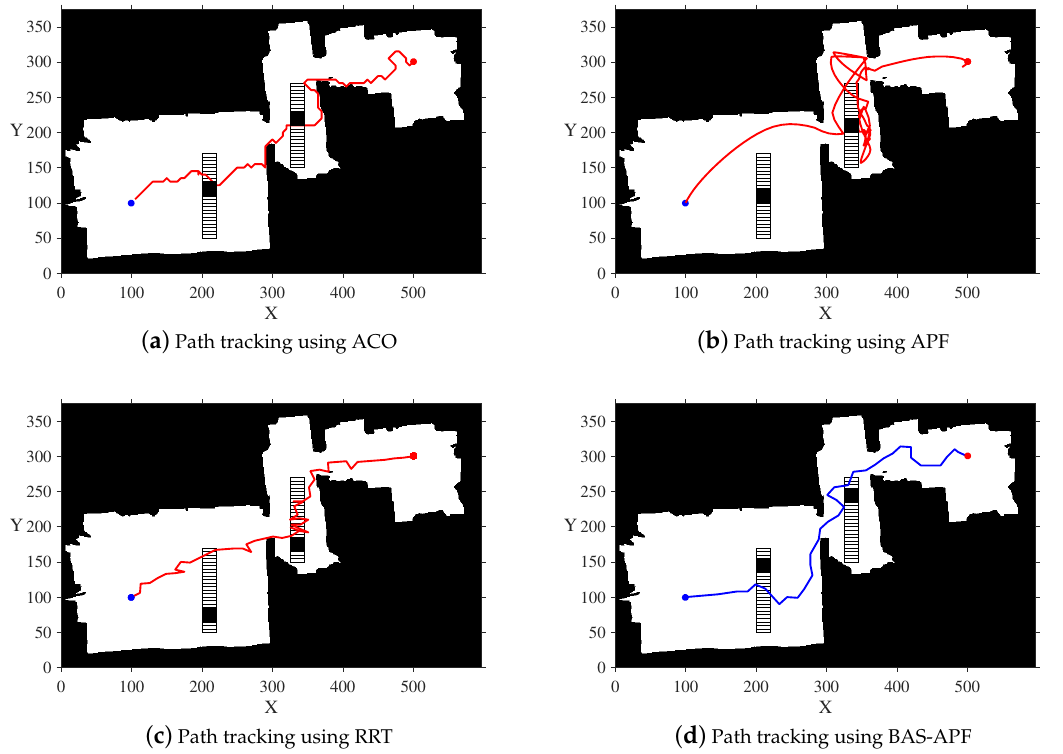
Figure 9. Comparative simulation results on a map with vertical dynamic obstacles.